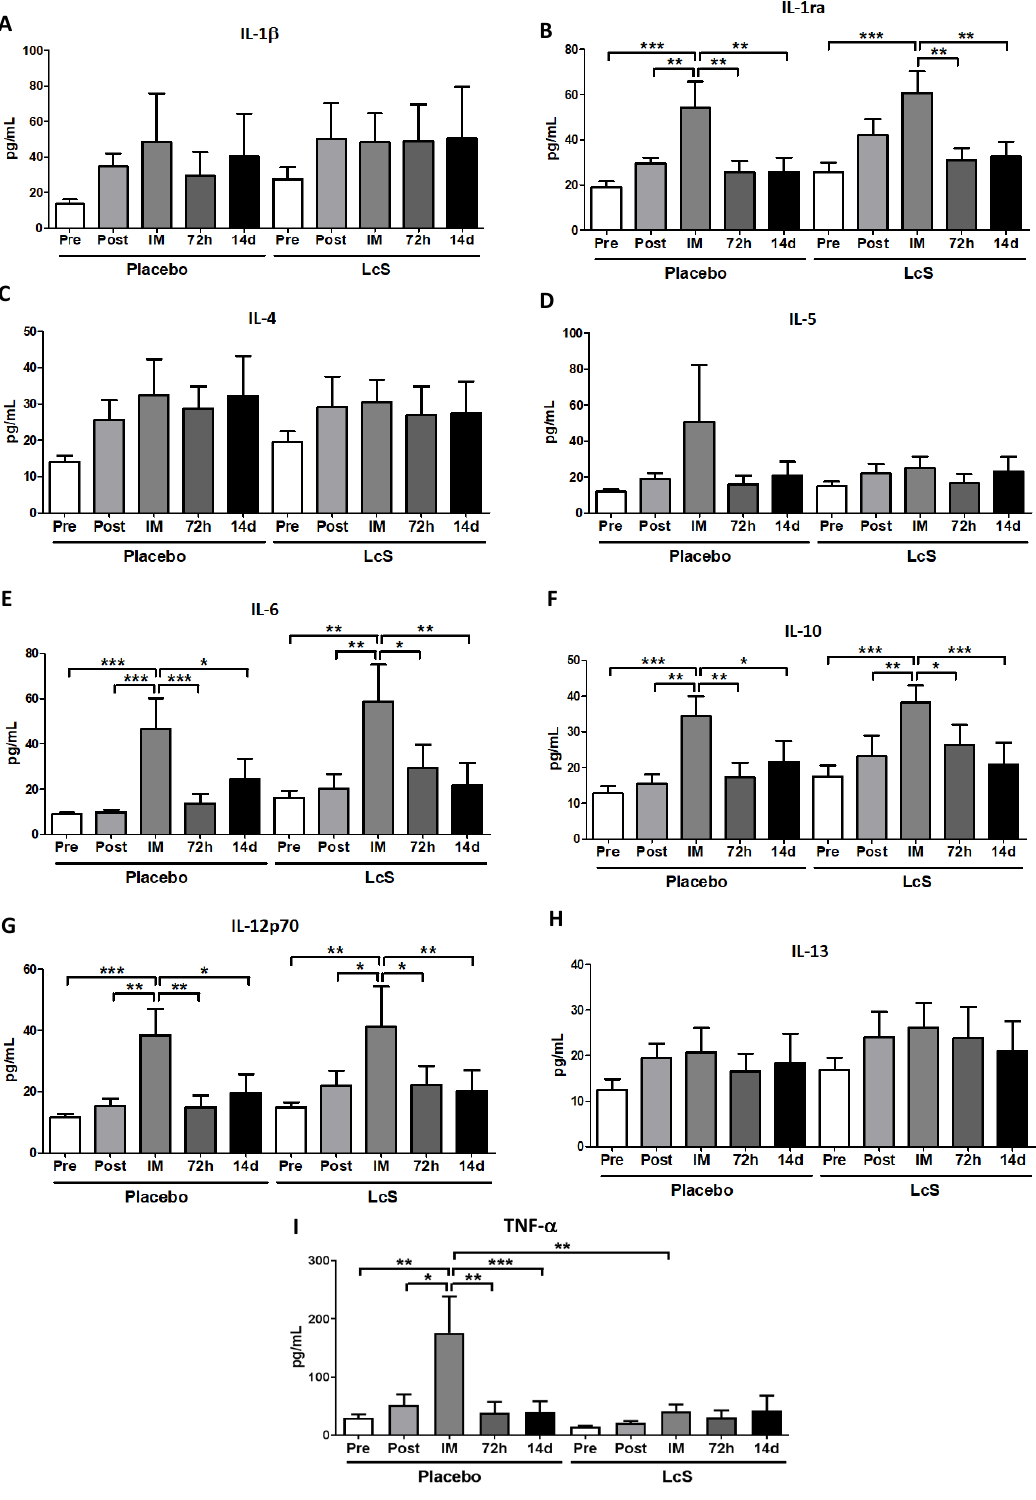
Figure 5. LcS increase systemic IL-12p70 levels after the marathon Serum concentration (pg / mL) of IL-1 β ( A ) , IL-1ra ( B ) , IL-4 ( C ) , IL-5 ( D ) , IL-6 ( E ), IL-10 ( F ) , IL-12p70 ( G ), IL-13 ( H ), and TNF- ( I ) in the placebo and LcS groups at five di ff erent occasions: before (Pre) and 30 days after the ingestion of the fermented milk containing or not containing LcS (Post-ingestion); immediately (IM); 72 hours (72 h) and 14 days (14 d) after the marathon. Values are presented in median with the respective quartiles. * p < 0.05; ** p < 0.01 and *** p <